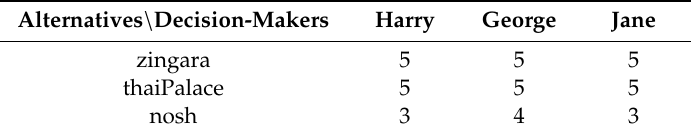
Table 5. Alternatives predicted importance to each